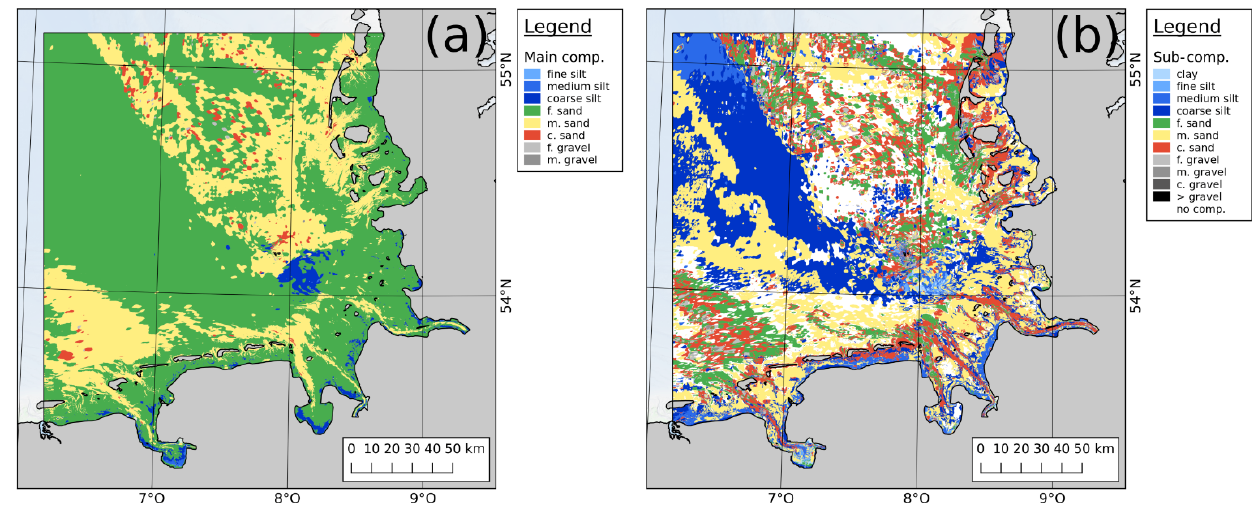
Figure 10. Petrographical maps based on the abbreviated German SEP3 standard for 1996: (a) main components and (b) sub-component.